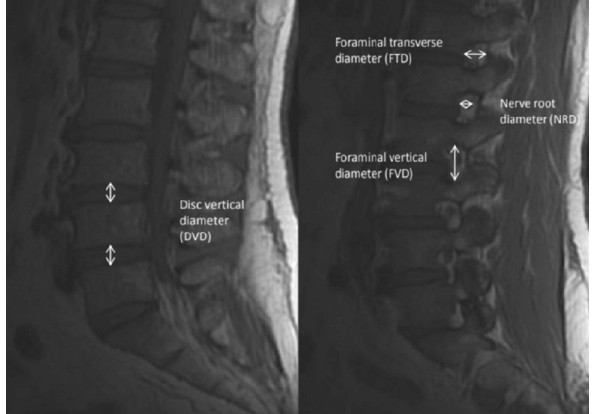
Methods of measuring disc vertical diameter (DVD), Fig. 1: foraminal transverse diameter (FTD), foraminal vertical diameter (FVD) and nerve root diameter (NRD).